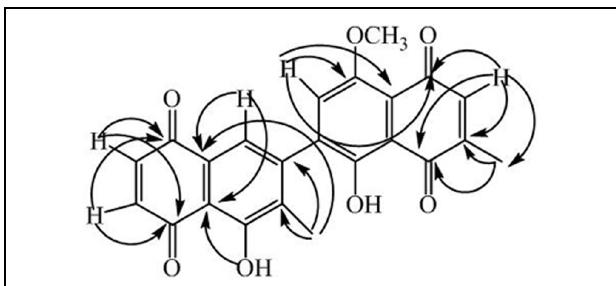
FIGURE 2 | Key HBMC correlations of compound 1.